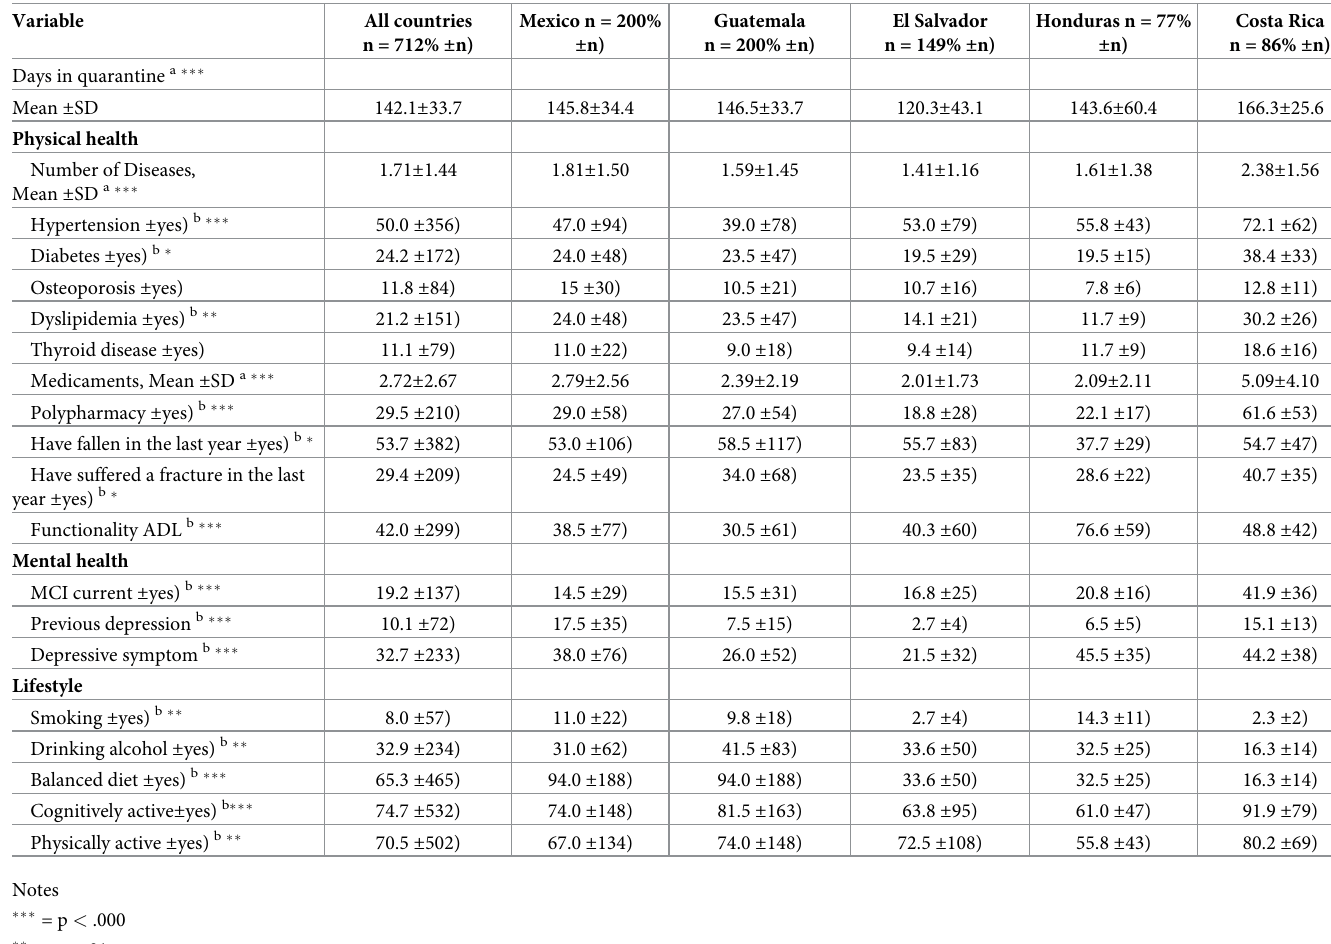
Table 2. Quarantine, health and lifestyle conditions of older persons in Centro American countries during pandemic due to COVID-19.